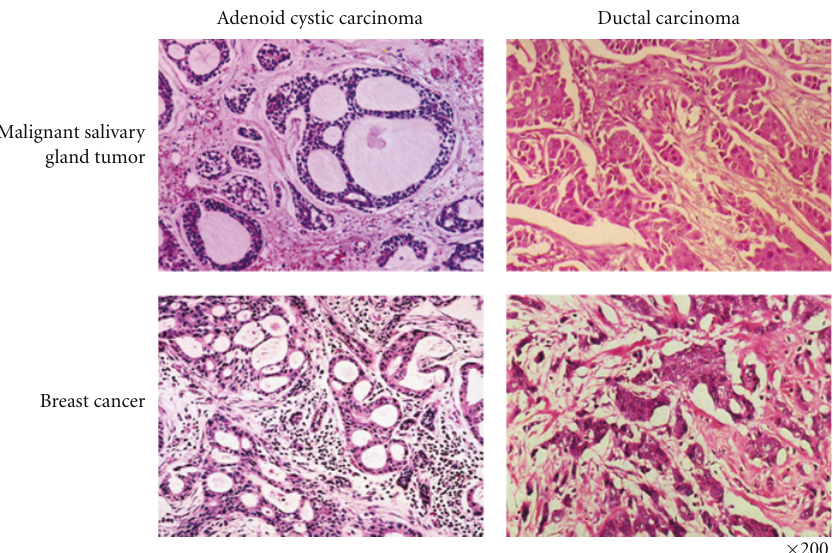
Figure 1: Histological comparison of malignant salivary and mammary gland tumors . Salivary glands and mammary glands are both tubuloac- inar exocrine tissues sharing similar morphological features. It is, therefore, expected that the tumors originating from these two di ff erent glands would show similarities in their response to hormonal